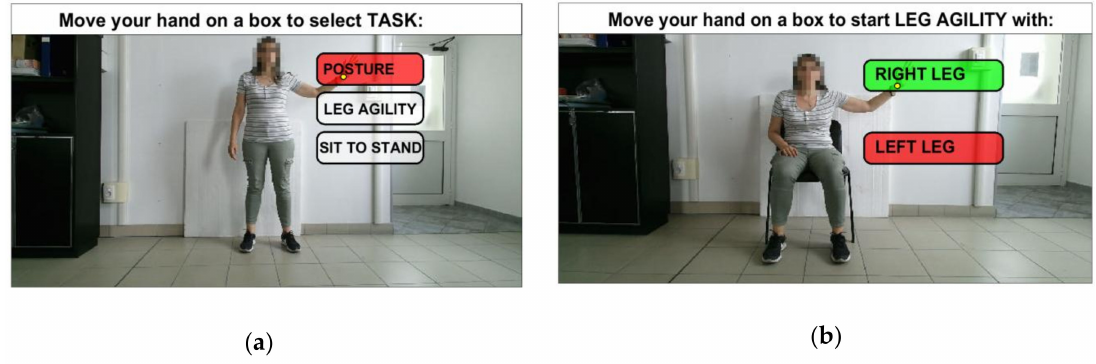
Figure 3. Gesture-based HCI: ( a ) GUI for the selection of lower limbs and postural tasks; ( b ) GUI for the selection of left/right leg before starting LA